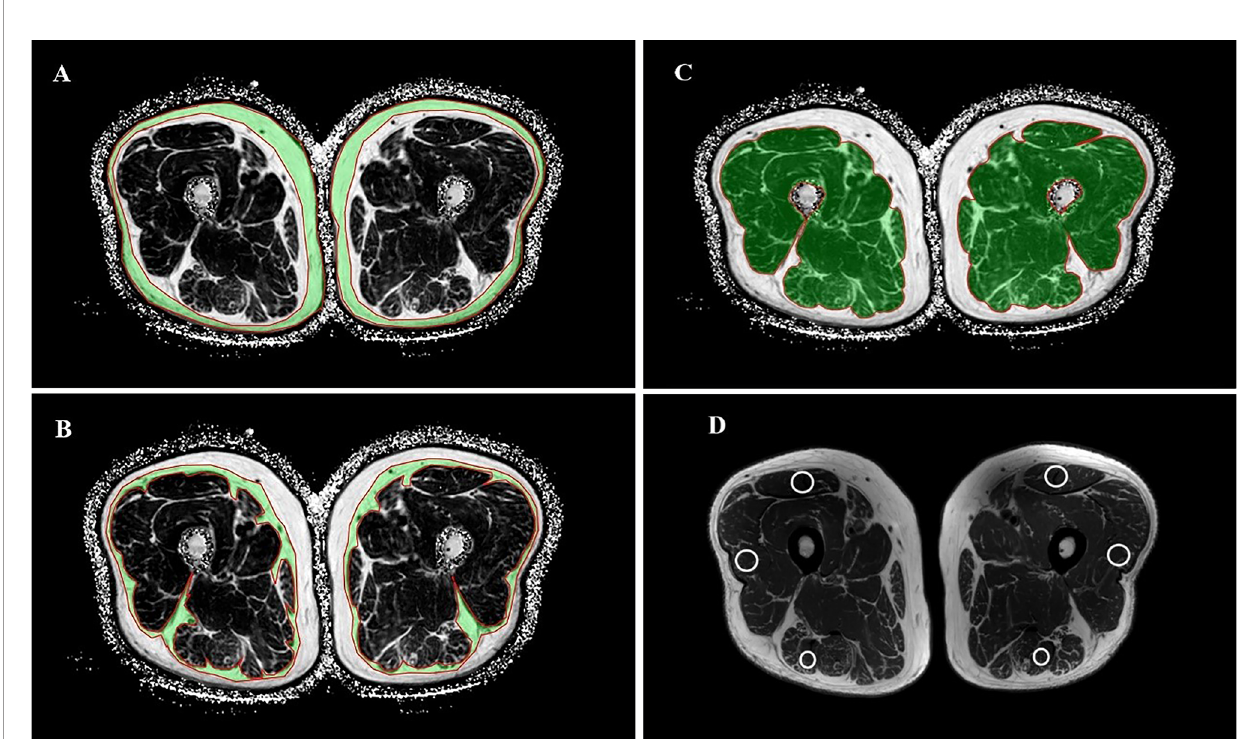
FIGURE 2 | Selection and measurement of mDixon-Quant sequence, T2mapping and DTI sequence ROI. Regions of interest for SAT (A) , SFAT (B) , IMAT (C) , and the positions of the ROI on the rectus femoris, the biceps femoris and the lateral femoral muscle in T2 sequence (D) .